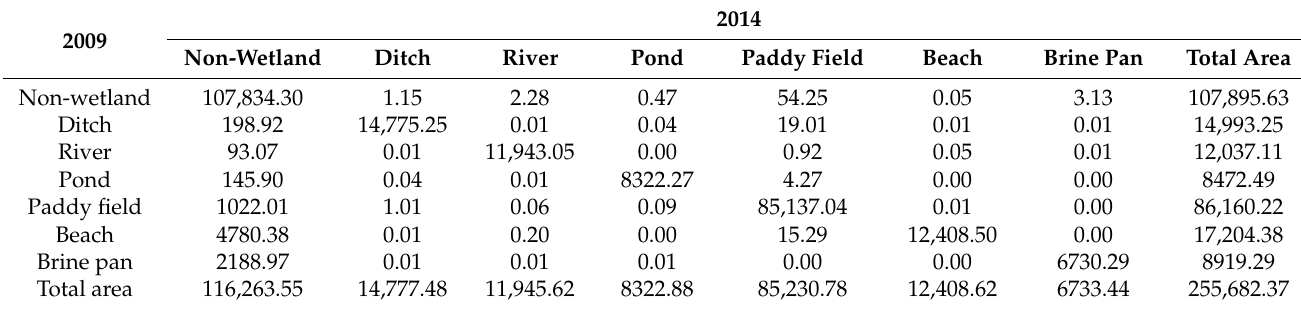
Table 6. Area of the landscape conversion matrix from 2009 to 2014 (hm 2 ).